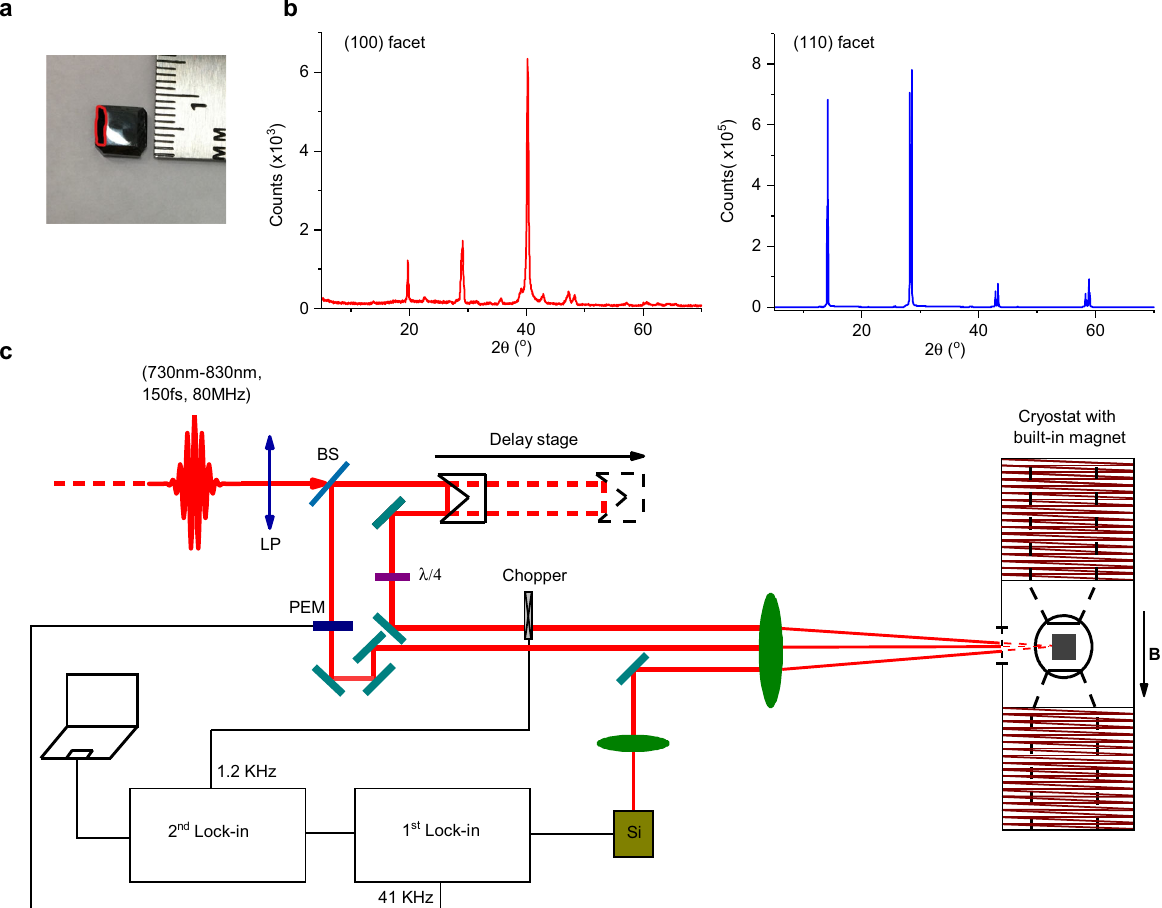
Fig. 1 MAPbI 3 crystal, X-ray diffraction patterns and experimental set-up. a MAPbI 3 single crystal where the (110) surface is in front and (100) surface is on the left (marked by a red line). b X-ray diffraction patterns of (100) and (110) crystal facets. c Schematic of the experimental apparatus for pump – probe transient photoinduced circular-polarized re fl ection, c-PPR(t). PEM is a photoelastic modulator for modulating the pump-beam polarization between left and right circular polarizations; λ /4 is a quarter-wavelength plate; LP is a linear polarizer; and BS is a beam-splitter. The MAPbI 3 crystal was mounted in a cryostat and cooled down to 4 K. An electromagnet generates a magnetic fi eld B up to 700 mT parallel to the crystal surface (Voigt